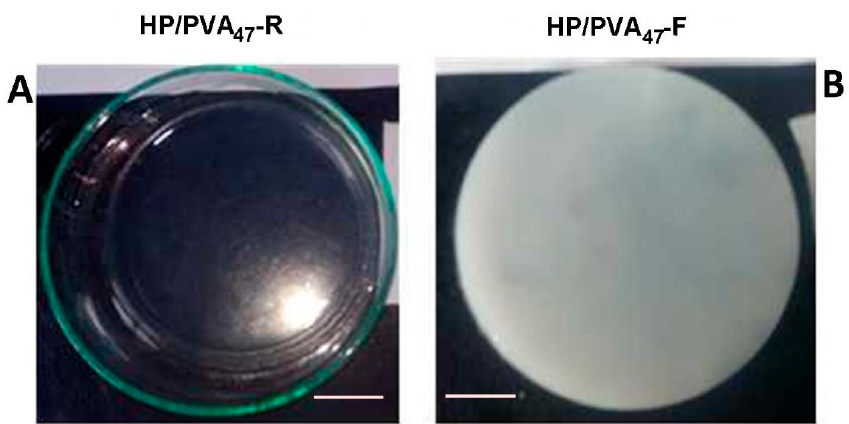
Figure 1. Optical images of HP / PVA 47 composite hydrogels obtained by chemical crosslinking at room temperature (panel A ) and by combined procedure (chemical and freeze-thawing cycles) (panel B ). Bar corresponds to 1 cm.